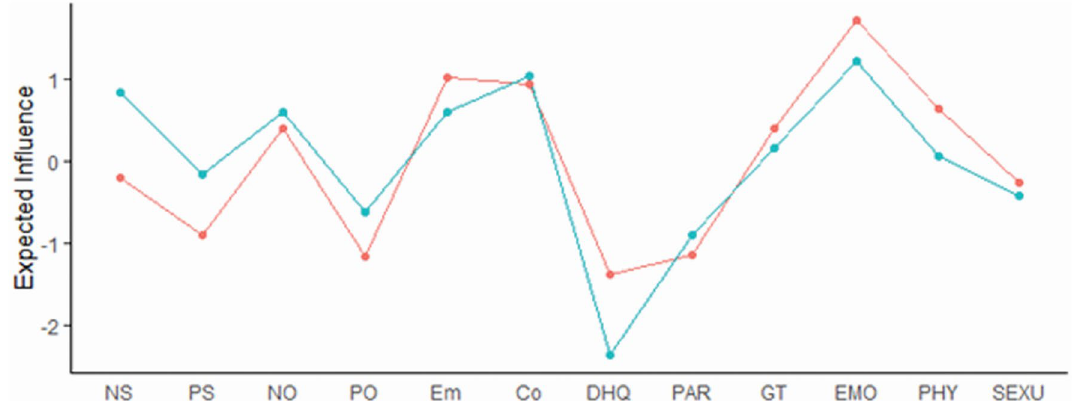
Figure 2. Expected influence for patients (red) and controls (blue). Abbreviation: Co, Cognitive subscale of the BS; DHQ, Dietary Habits Questionnaire; Em, Emotional subscale of the BS; EMO, Emotional abuse of the ETI; GT, General Traumatic experiences of the ETI; NO, Negative-Others of the BCSS; NS, Negative-Self of the BCSS; PAR, Physical Activity Rating; PHY, Physical abuse of the ETI; PO, Positive-Others of the BCSS; PS, Positive-Self of the BCSS; SEXU, Sexual abuse of the ETI The R-packages ‘mgm (version 1.2-12 and URL https:// CRAN.R- proje ct. org/ packa ge= mgm)’ and ‘qgraph (version 1.6.9 and URL https:// CRAN.R- proje ct. org/ packa ge= qgraph)’ were